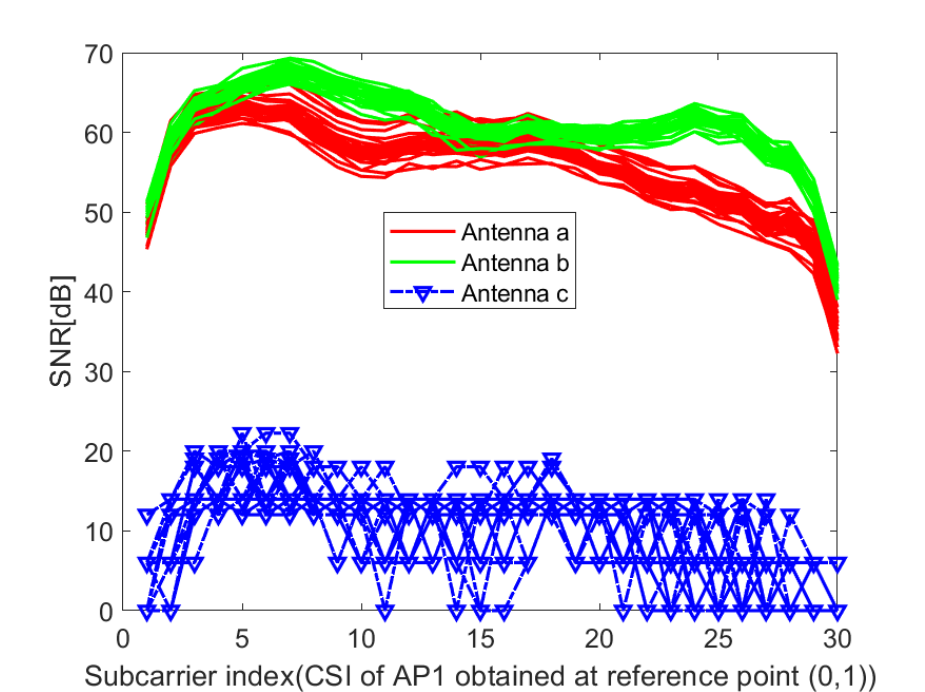
Figure 7. Raw CSI obtained on different receiving antennas at reference point (0,1) of AP1 in the lobby of IT2